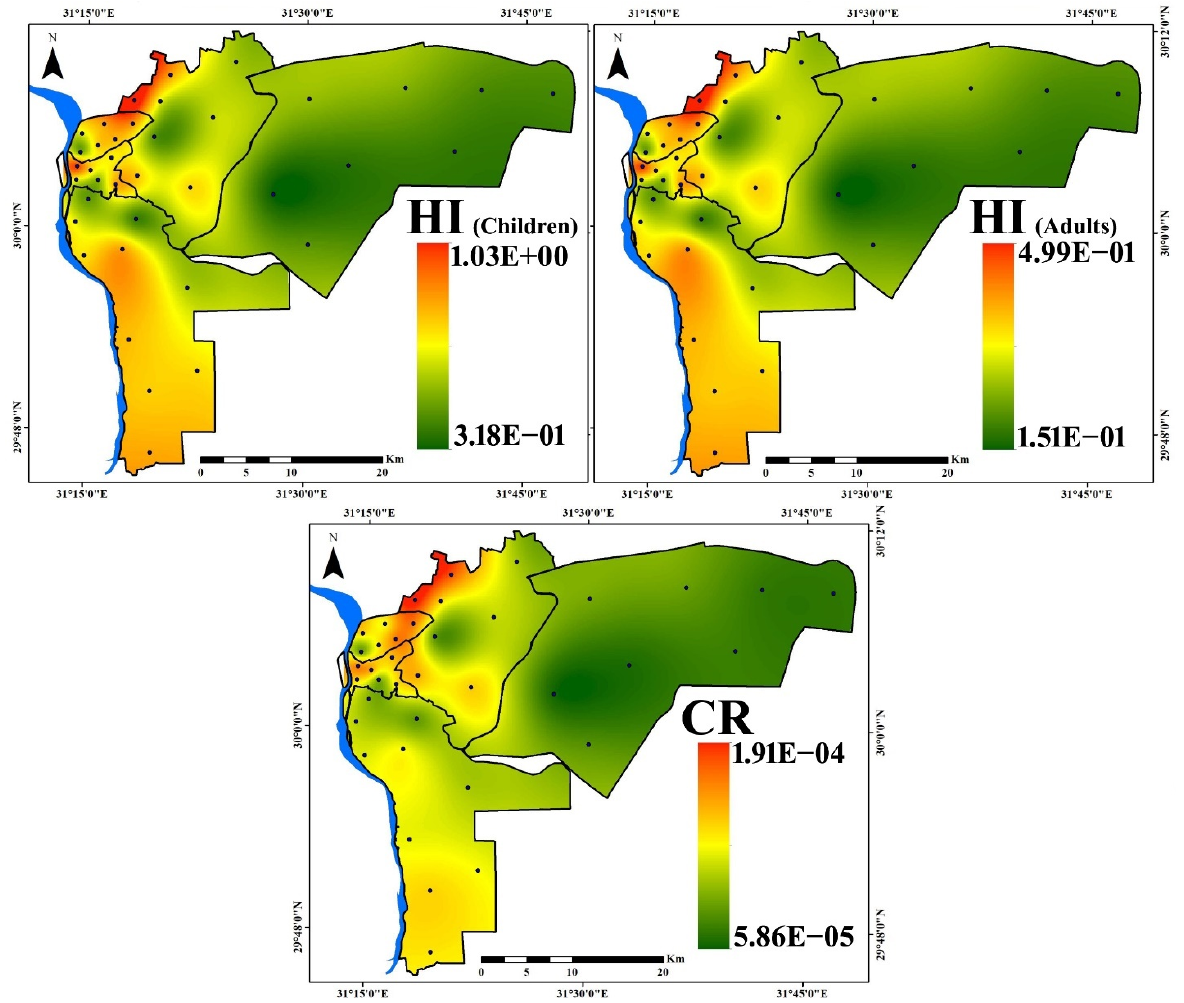
Figure 9. Spatial distribution of HI for children and adults and CR risks for the household dust exposure in Cairo City.